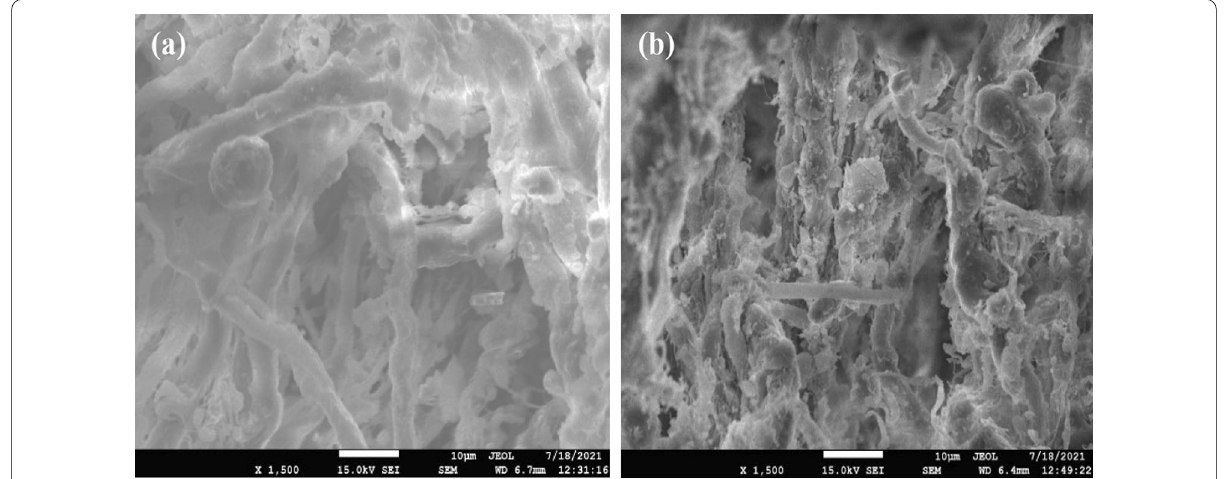
Fig. 8 FESEM images of the cross-section of leather tanned with a conventional vegetable tannin and b X. granatum tannin